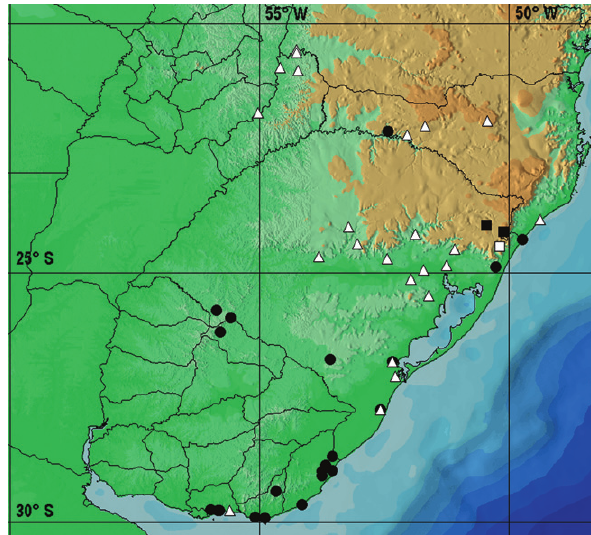
Figure 24. Records of distribution of the four species of Parampheres in East-Southeastern South America: P. bimaculatus ( (cid:122) ); P. lucidus ( (cid:132) ); P. pectinatus ( (cid:85) ); and P. tenebris sp. nov. ( (cid:133)